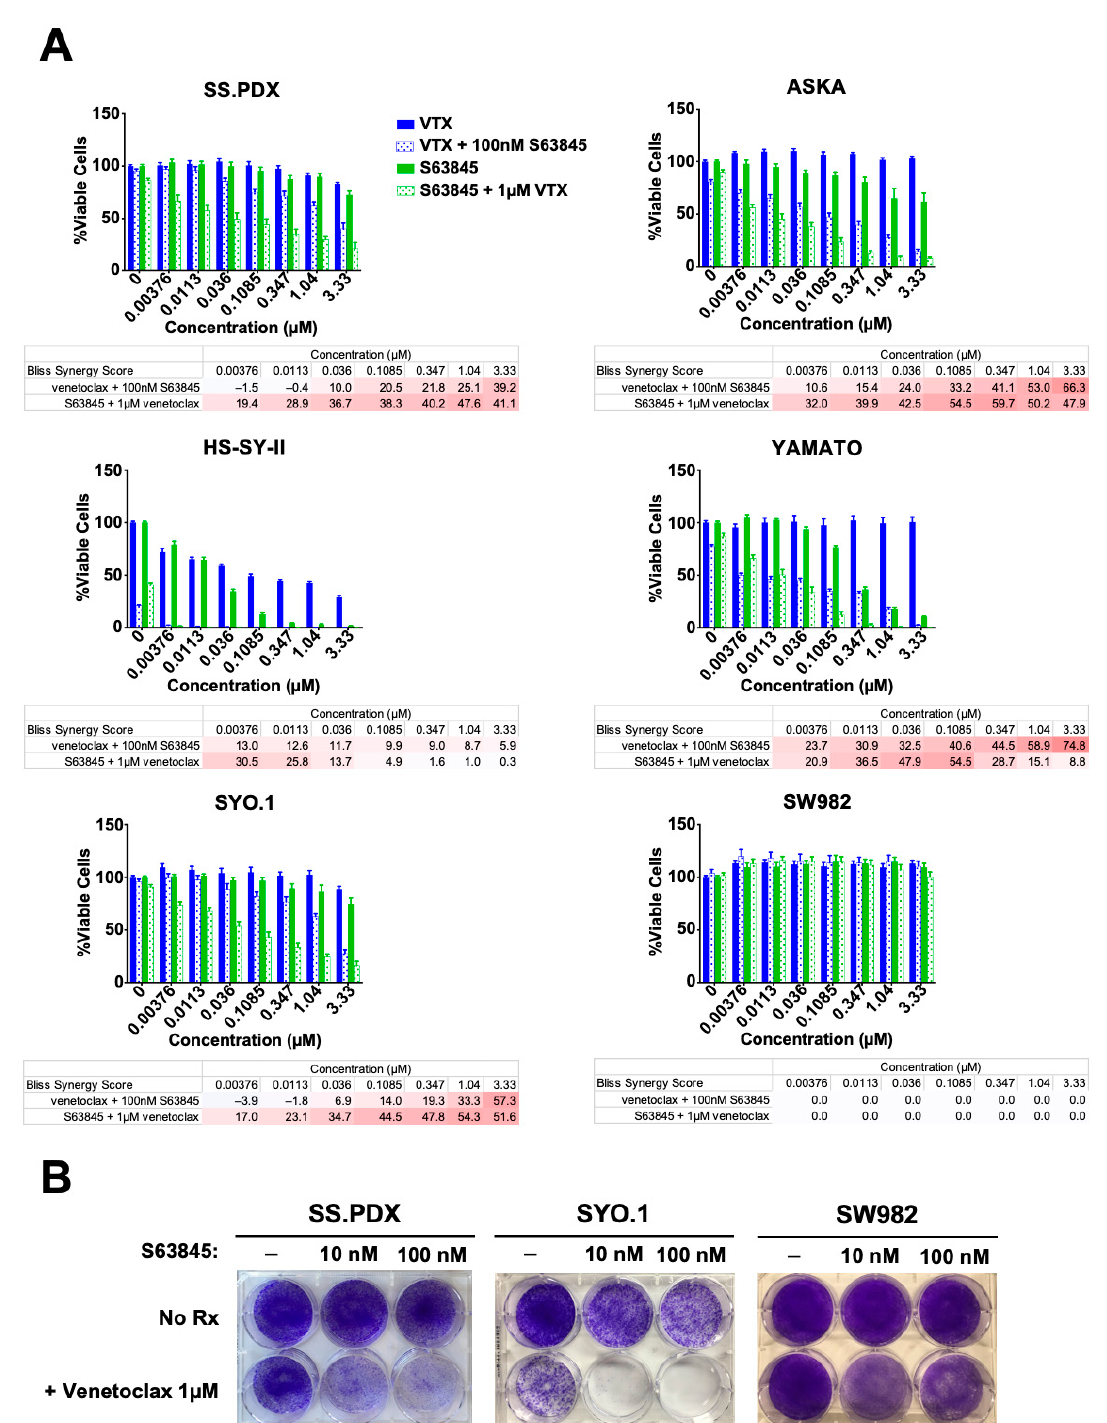
Figure 3. The MCL-1 inhibitor S63845 and VTX combine synergistically to reduce cell viability. ( A ) Scheme 1. and the atypical SS cell line SW982 were treated with increasing concentrations of VTX (blue bars) or S63845 (green bars), alone (solid bars) or in combination (hollow bars). Cells were treated for 72 h and cell viability was measured using CTG. Error bars indicate SEM. Bliss synergy scores are displayed, ranging from –100 (blue) to +100 (red). ( B ) Crystal violet staining of SS.PDX, SYO.1, and SW982 cells after 7-day treatment with S63845 or VTX, alone or in combination, at the concentrations indicated.